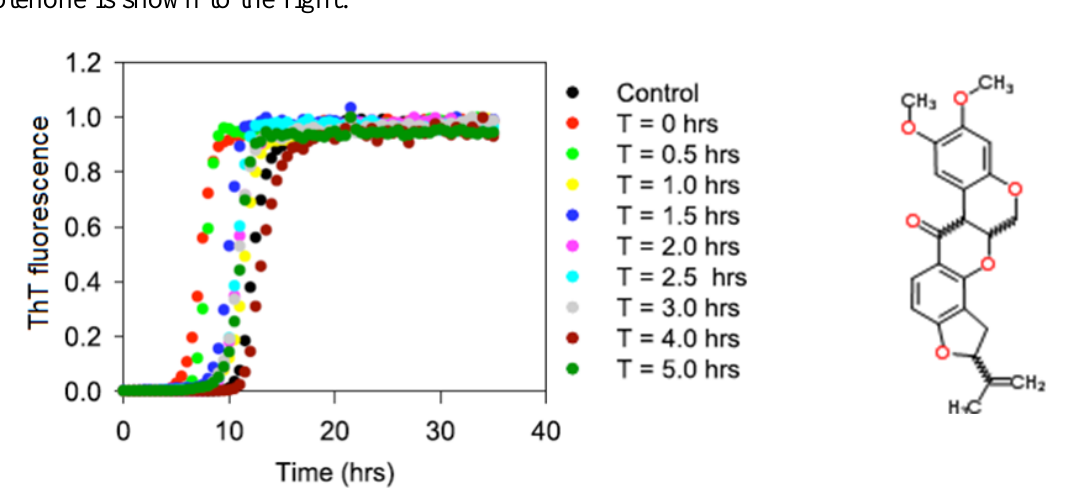
Figure 1. The effects of rotenone on α-synuclein fibrillation. T indicates the time during the fibrillation process at which rotenone was introduced. Chemical formula of rotenone is shown to the